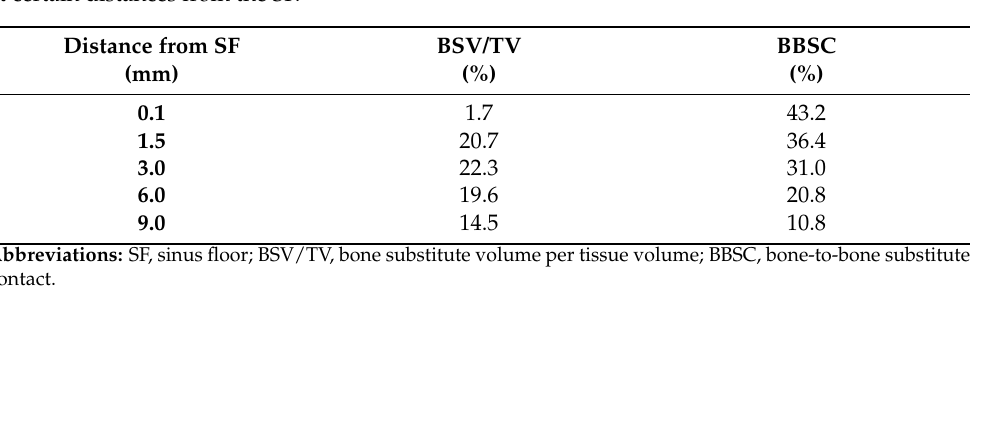
Figure 2. Scatter plots including a regression line illustrating the vertical distribution of the primary parameters BSV/TV and BBSC over serial zones of 100 µ m across the entire length of biopsies starting from the native bone of the SF (0 mm zero reference) towards the apical end of the biopsies. ( A ) BSV/TV: In immediate proximity to the SF, expected BSV/TV was very low. At a distance of approximately 3 mm from the SF, it reached a maximum with 22.9% before it steadily decreased with increasing distance from the SF. Both, the logarithmic increase of BSV/TV (most evident within the first 1.5 mm) and the linear decrease were statistically significant ( p < 0.001). ( B ) BBSC: The few, mostly large particles that were typically located in the area close-by the SF (0–1.5 mm) were well integrated into newly formed bone. At a distance of approximately 0.1 mm from the SF, 41.0% of the BS surface was in contact with new bone. With increasing distance, BBSC decreased steadily. The linear decrease of BBSC with distance from the SF was statistically significant. ( p < 0.001). BSV/TV: bone substitute volume per tissue volume; BBSC: bone-to-bone substitute contact; SF: sinus Table 2. Regression predictions for the primary measurements BSV/TV and BBSC in 0.5 mm windows at certain distances from the SF.